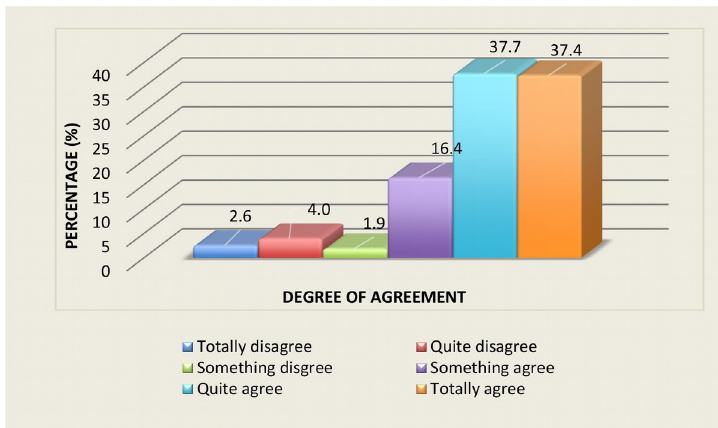
Figure 5. Percentages of responses given on the need for training in the didactic use of